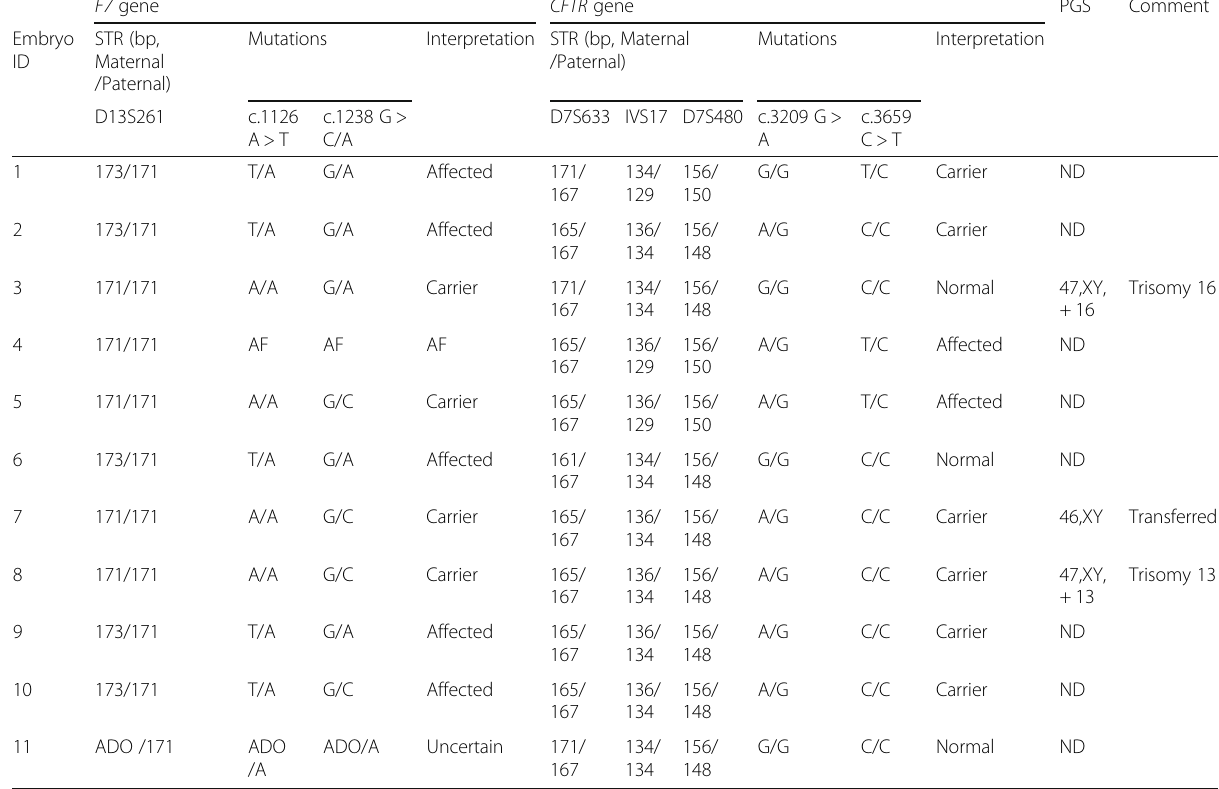
Table 2 The results of mutation anlaysis and comprehensive aneuploidy screening F7 gene CFTR gene Embryo STR (bp, ID